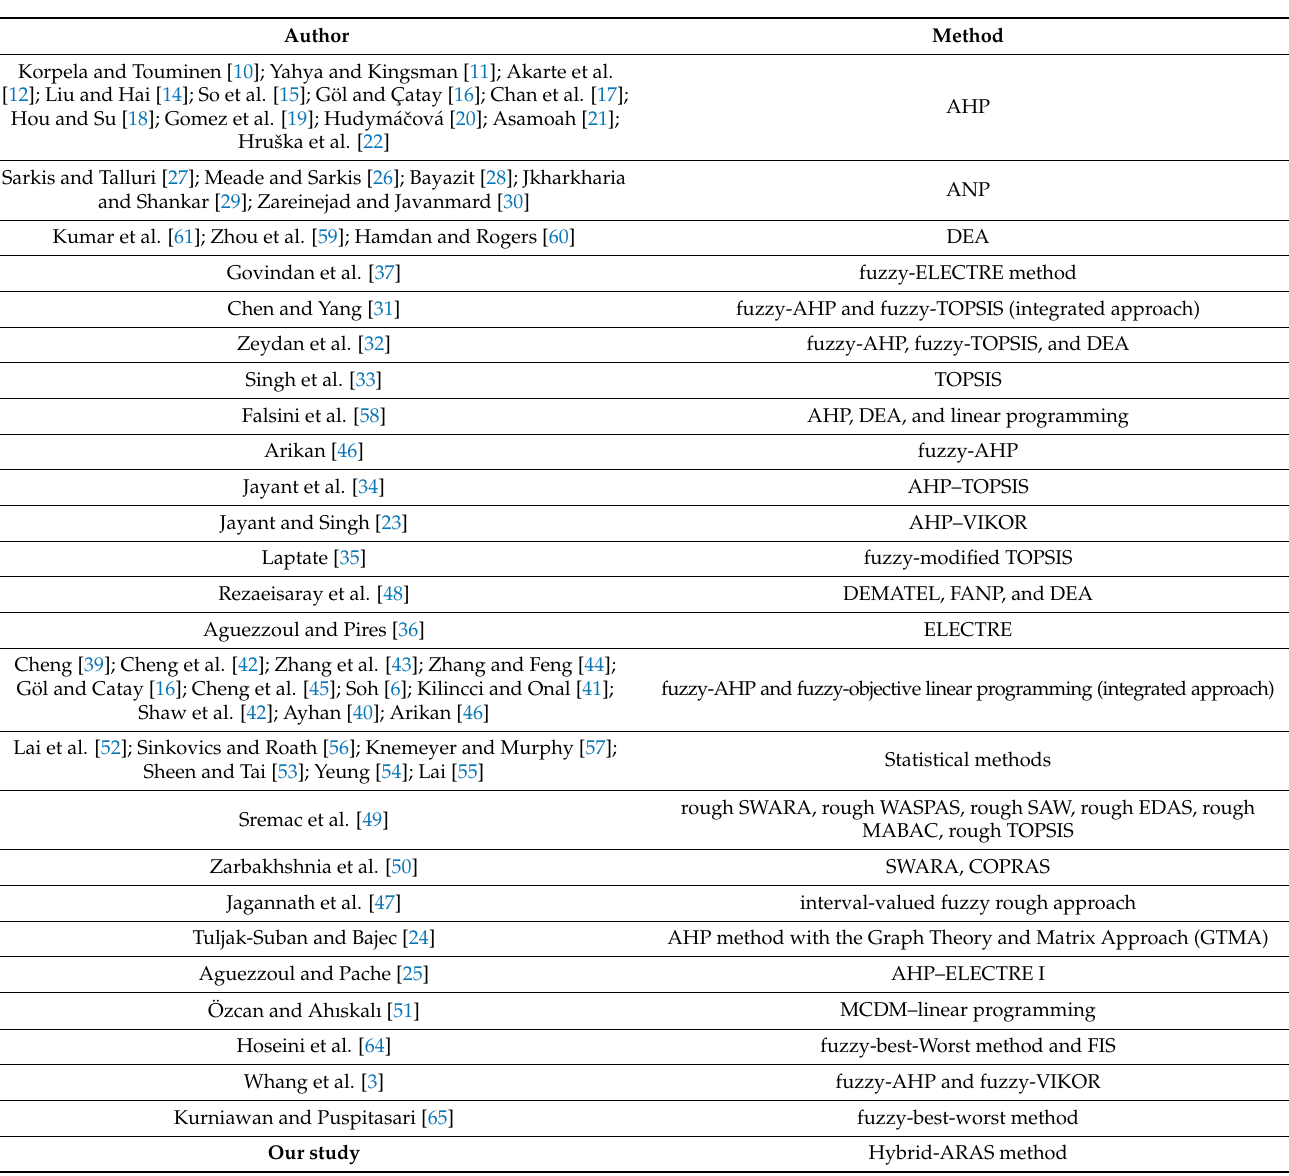
Table 1. Review based on the methods for 3PL evaluation and